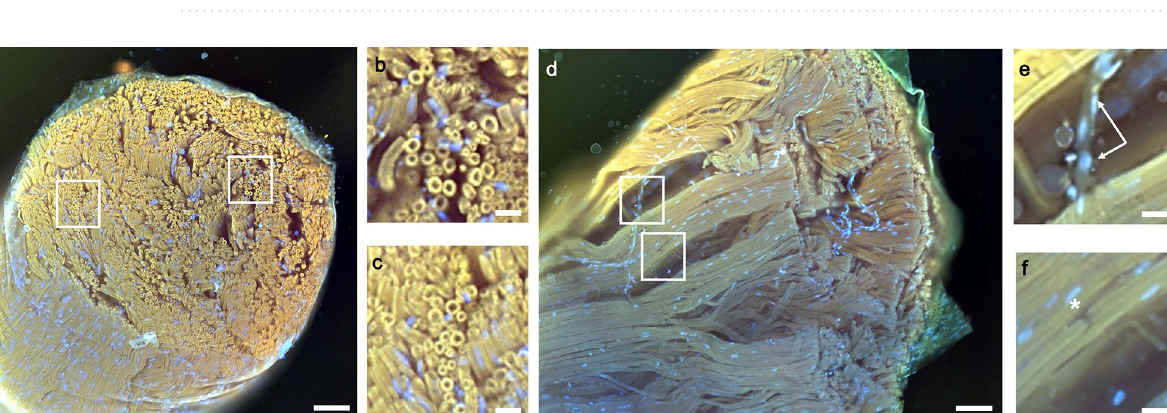
Figure 1. 2D-MUSE image of a rat sciatic nerve. Fixed nerve tissue was sectioned on a compresstome and laid immediately on a quartz slide for imaging. Individual myelinated fibers are visible ( b and c ) with contrast originating from tissue autofluorescence under UV illumination. ( d ) Manual segmentation on a subset of myelinated fibers in ( b ) allows quantification of axon diameters and corresponding g-ratios, displayed as histograms in ( e ). Scale bars are: ( a ) 100 µm, ( b and c ) 50 µm. Close-up views in ( b ) and ( c ) were contrast enhanced to improve visibility of myelin sheaths.